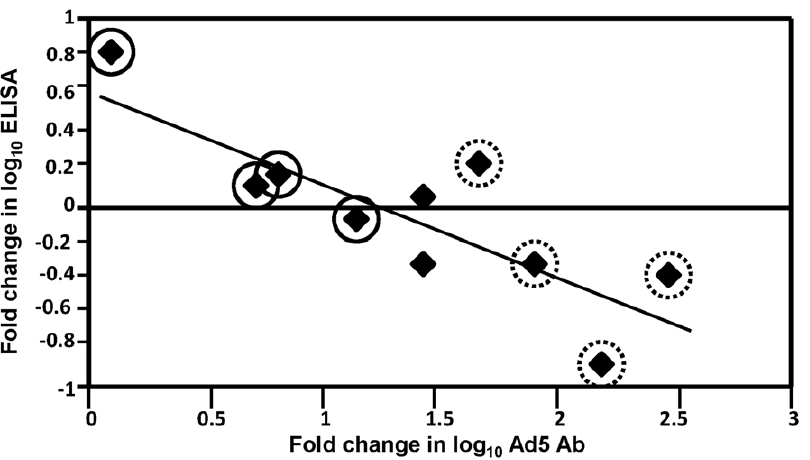
Figure 11. Negative Correlation between Fold Increase in Ad5 NAb Titer and Fold Change in CSP ELISA Titer. The ratio between Ad5 NAb titers induced by the first immunization (measured at 1 month) and titers prior to the first immunization (fold increase) was negatively correlated with the ratio between CSP ELISA titers induced by the second immunization (at 19 days) and titers induced by the first (at 1 month) (fold change). Volunteers with absent pre-existing immunity prior to the first immunization (titer , 12, dotted circles) showed the greatest fold increase in NAb and, overall, the poorest boosting of antibody responses to CSP, while the volunteers with the highest pre-existing immunity (titer . 500) (solid circles) showed the least fold increases in NAb and, overall, better boosting of antibody responses.